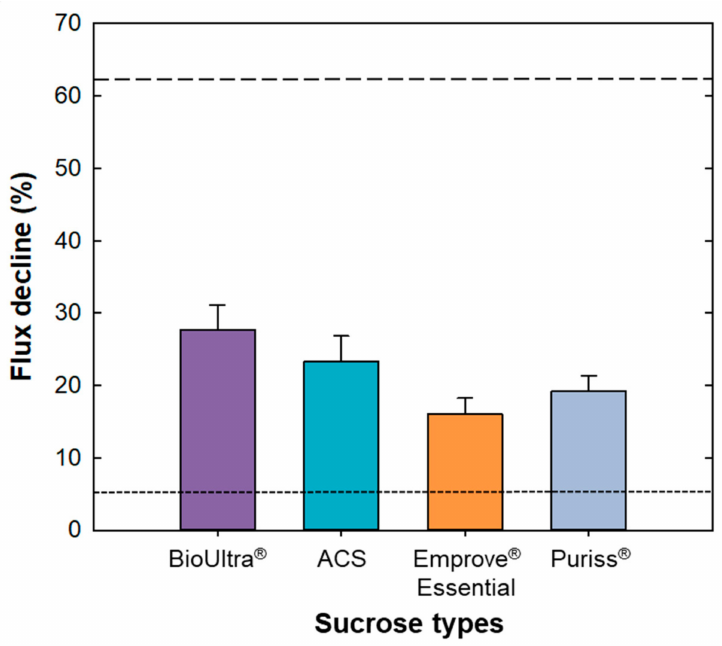
Figure 8. Flux decline using the normal flow filtration system with different types of sucrose (20 mM histidine at pH 6 with 100 mM sucrose solution). The upper dashed line indicates the flux decline using the sucrose with impurities and the dotted line at the bottom indicates the flux decline, with only buffer owing to the pressure